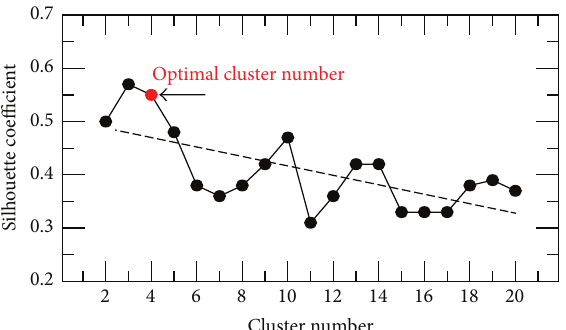
Figure 10: Silhouette coefficient (solid line with dots) at each cluster number using the Fuzzy Clustering Method (FCM) and its trend (dashed line). In this study, the optimal cluster number (red circle) was selected as four